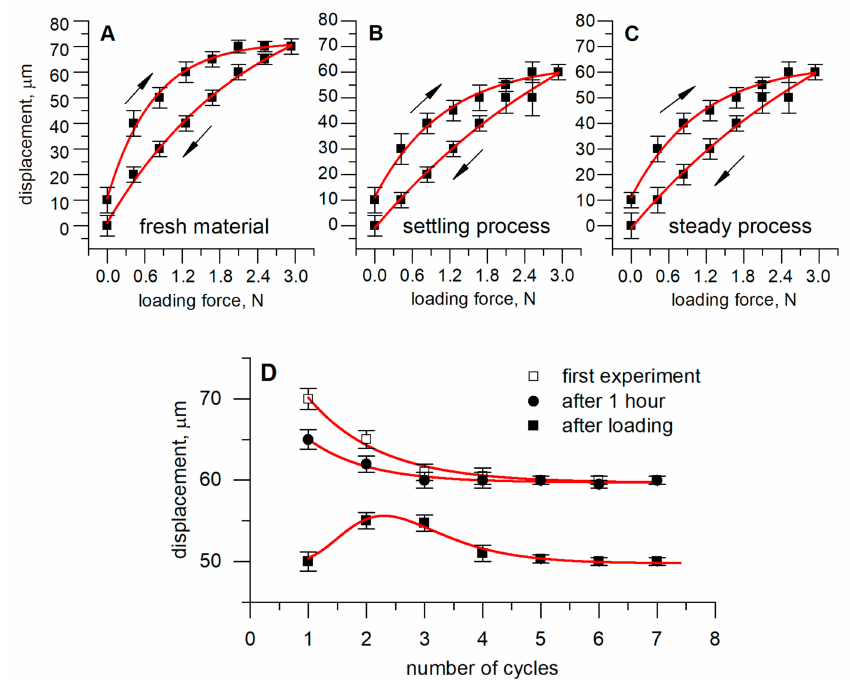
Figure 4. Dependence of sensor deformation on the applied load at di ff erent experimental conditions: ( A ) 1st cycle, new material; ( B ) 4th cycle, settling process; ( C ) 7th cycle, steady process; ( D ) displacement dependence on the number of experiments, performed at the beginning of the experiment, after 1-h lasting break during which sensor was unloaded, and after 1-h break during which sensor was loaded by 2.88